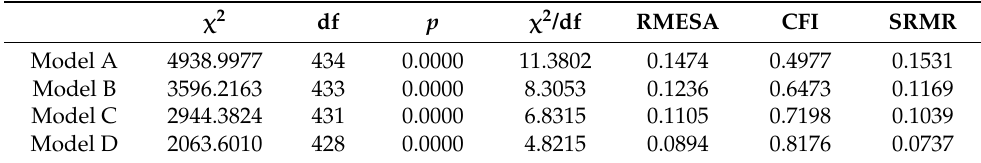
Table 4. Results of confirmatory factor analysis.